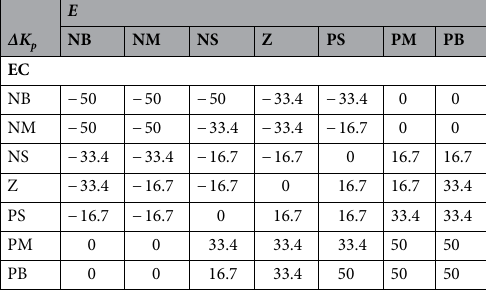
Table 2. Fuzzy control rules of Δ K p .